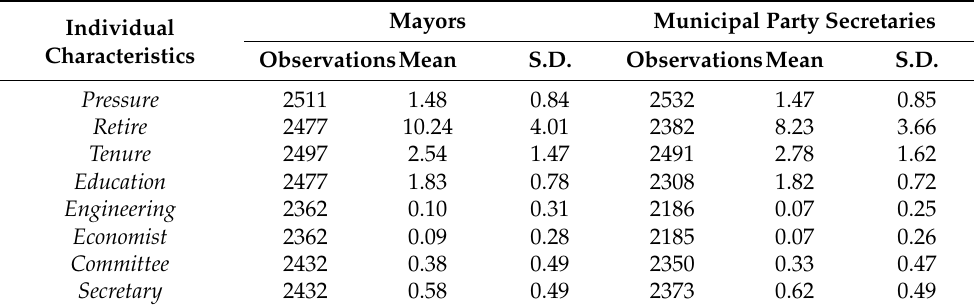
Table 1. Summary statistics of local